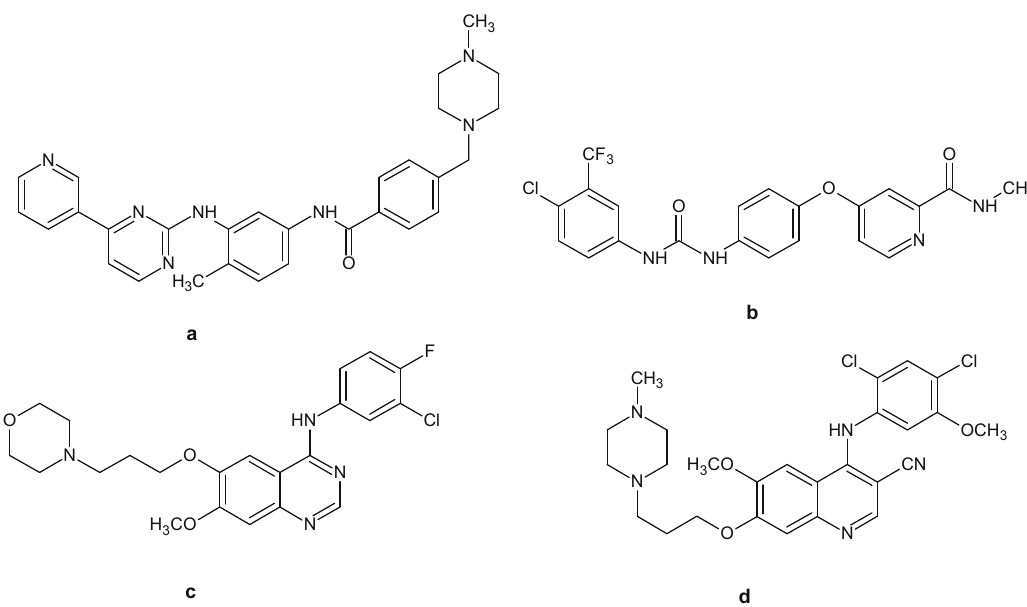
Figure 1: Chemical structure of imatinib ( a ) , sorafenib ( b ) , ge fi tinib ( c ) and bosutinib ( d )